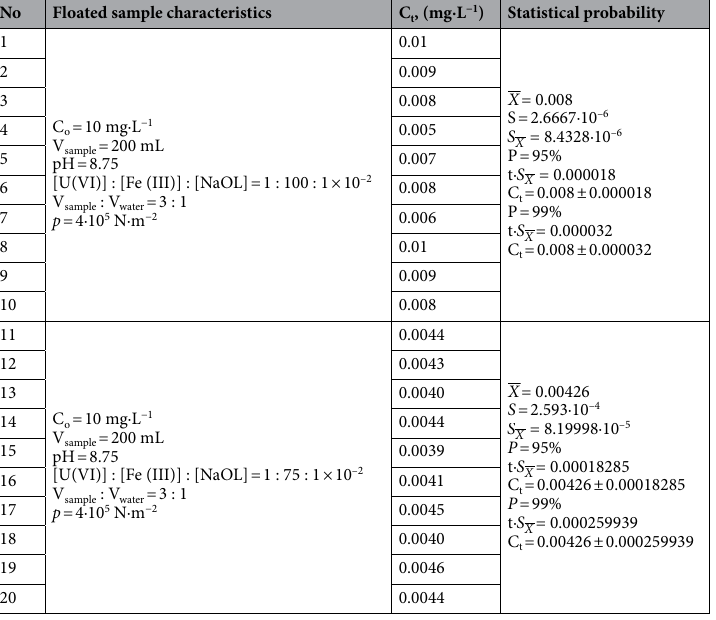
Table 3. Reproducibility of U(VI) removal by sorption/precipitate flotation. X mean of the samples. S standard deviation of one measurement. S X standard deviation of the mean. C t U(VI) concentration after flotation. P probability that C t be within a range of values. t t (Student) variable.